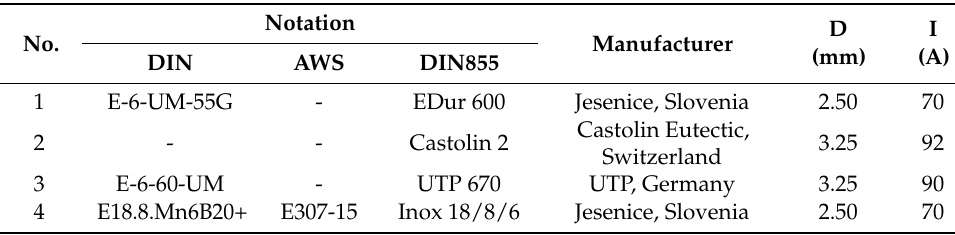
Table 3. Notation and sizes of the used filler metals and applied current intensity.